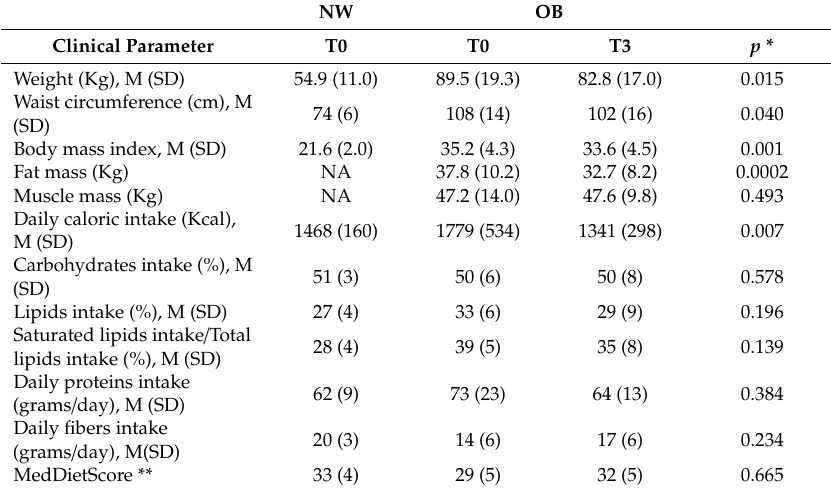
Table 2. Anthropometric measurements and nutritional intake in normal-weight controls (NW) at baseline and in overweight and obese patients (OB) before and after the nutritional